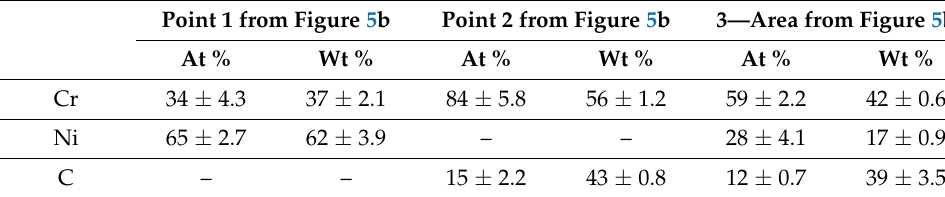
Table 4. Results of the chemical composition analysis of the CrC